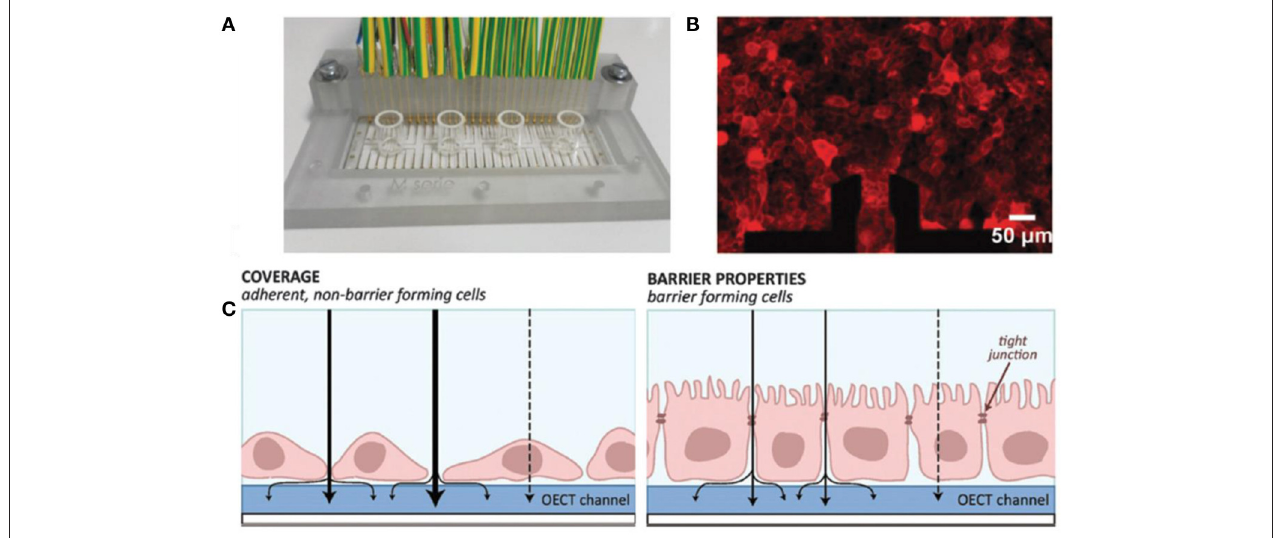
FIGURE 8 | The OECT device for monitoring adherent cells. (A) Measurement platform consisting of 24 OECTs divided between four glass wells. (B) MDCK II cells transfected with RFP actin construct seeded on device for fluorescence imaging. (C) Schematic diagram of the cell coverage with low ion flow through barrier (right) or high ion flow through non-barrier (left) (Ramuz et al., 2015). Reproduced with permission (Ramuz et al., 2015). Copyright © 2015 The Royal Society of Chemistry.